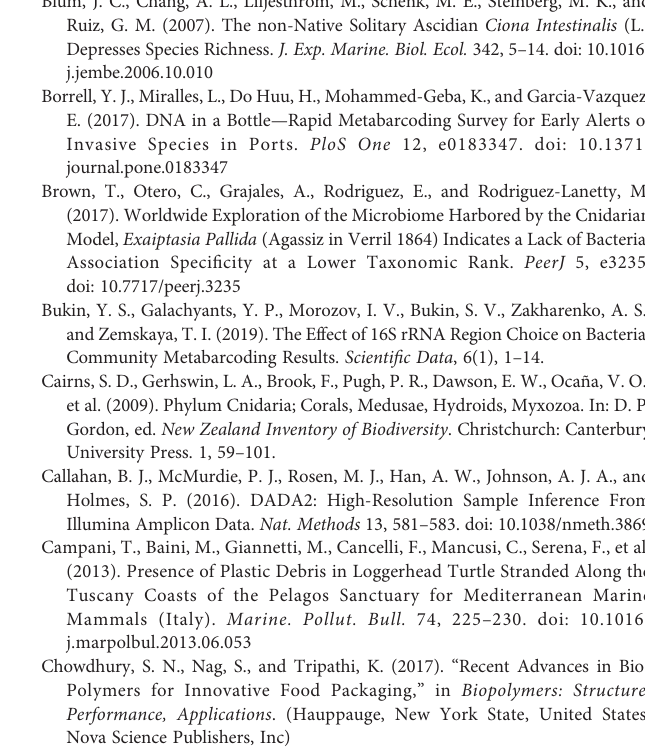
Signi fi cant values are highlighted in bold. Supplementary Table 5 | Inventory of non-indigenous species (NIS) detected in the present study. Supplementary Figure 1 | Line graph of time (weeks) vs . Temperature (°C). Supplementary Figure 2 | Phylogenetic tree representing all bacterial Amplicon Sequence Variants (ASVs) detected in our study and highlighting their family af fi liation, which were identi fi ed as having potential plastic-degrading capabilities. The taxa with reports of plastic degradation were identi fi ed using the PlasticDB webserver (http://www.plasticdb.org/), which contains 562 microbial species. The phylogenetic relationship among the shown taxa was extracted from the NCBI taxonomicdatabase (Schochetal., 2020).Thereisatotalof294bacterialfamilies in our study that were successfully processed by the PlasticDB tool, resulting in 41